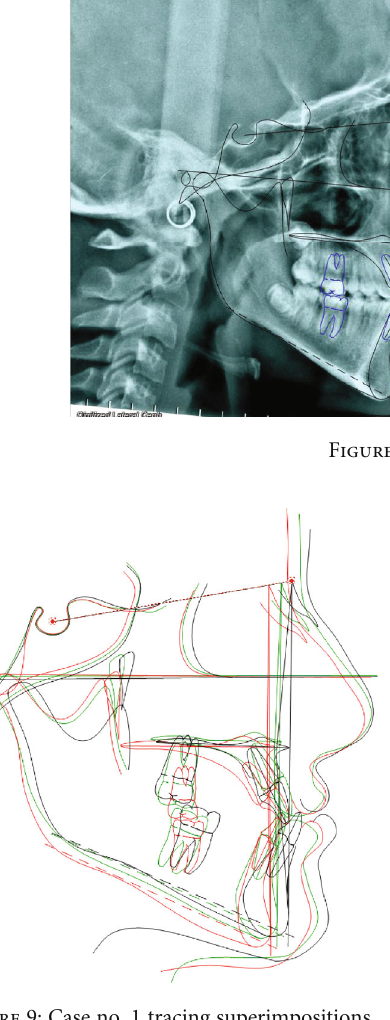
Figure 9: Case no. 1 tracing superimpositions.